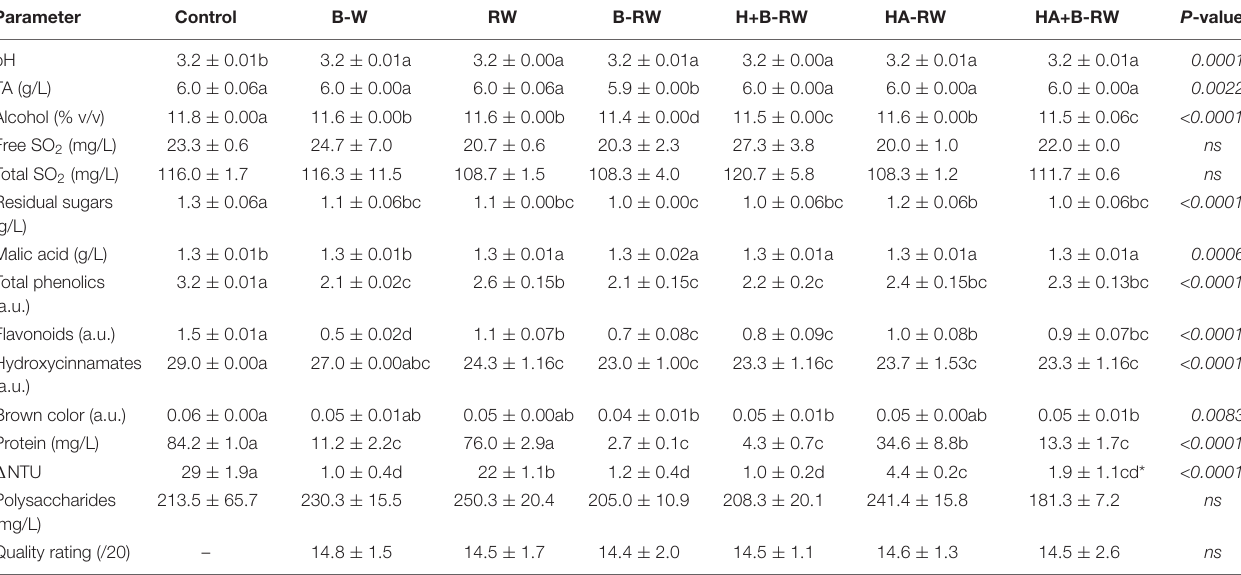
TABLE 1 | Basic chemistry, color, macromolecule composition, heat stability and quality ratings of untreated wine (Control), wine treated via bentonite fining (B-W) as a positive control, and recombined wines (RW) following ultrafiltration/heat/protease treatments; B denotes bentonite addition; H denotes heating (10 min at 62 ◦ C); A denotes Aspergillopepsin enzyme addition (DSM 0.05%